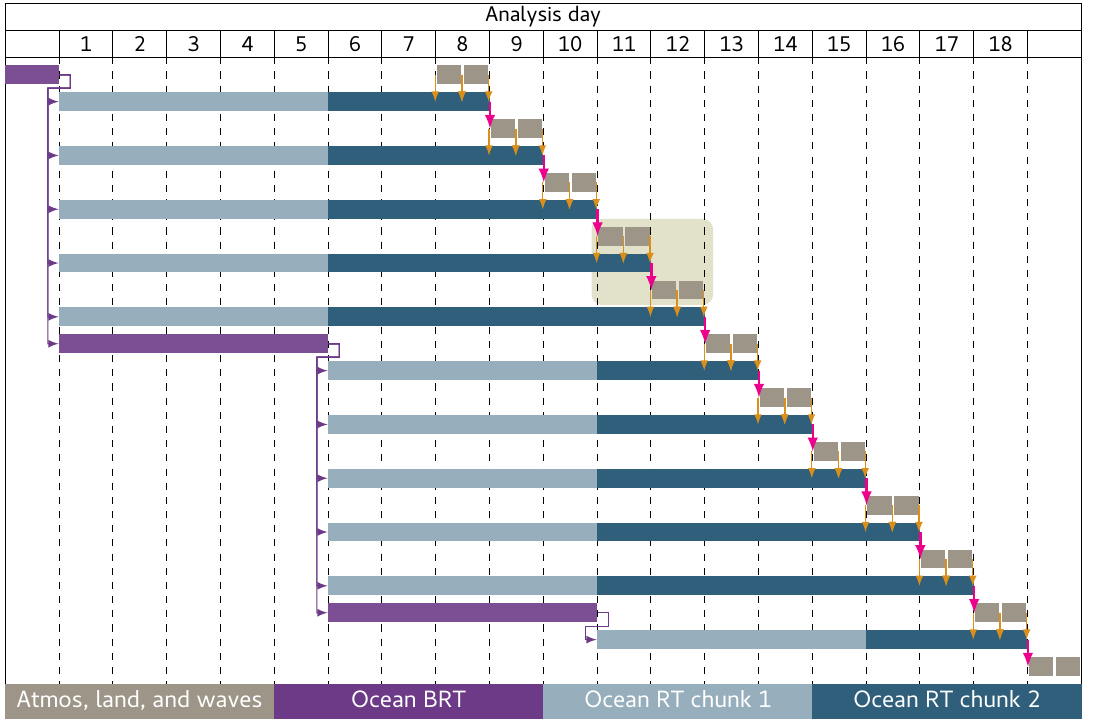
Figure 3. Weakly coupled assimilation system information flow. Horizontal bars represent the analysis window for the various different components of the system. This is a simplified plot ignoring a 3 h offset of the systems. Orange arrows show the existing transfer of forcing from the atmosphere to the ocean. Magenta arrows show the addition using the OCEAN5 fields as the lower-boundary condition for the atmospheric analysis, thus forming the weakly coupled data assimilation (WCDA) system. The highlighted region is discussed in an example in the